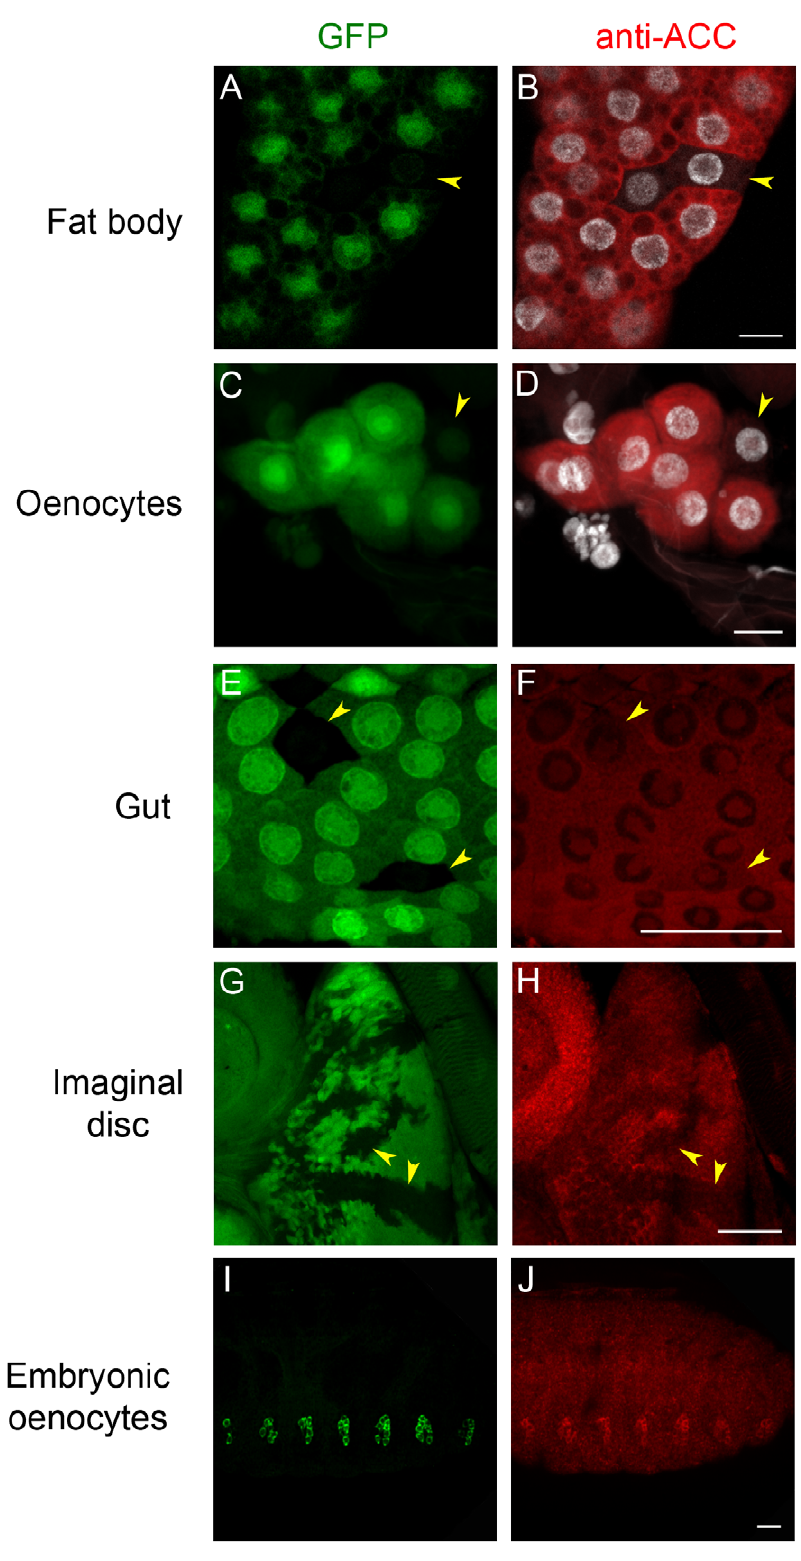
Figure 1. Immunodetection of ACC. Direct GFP fluorescence (A,C,E,G), and staining to ACC (B,D,F,H,J) and nuclei (B,D). ACC expression was very high in the FB (B) and in the oenocytes (D) of L3 larvae, and thus detection was performed with very low laser intensity. The ACC signal was lower in the gut (F) and in the imaginal discs (H) of L3 larvae, and thus detection was performed with high laser intensity. Specificity of the ACC signal was monitored by generating homozygote FRT - ACC B131 clones (identified by the lack of GFP staining; arrowheads in A,C,E,G), which do not express the ACC protein in the corresponding pictures (arrowheads in B,D,F,H respectively). In the embryo, the strongest ACC staining was observed in the oenocytes (J) co-labeled to GFP driven by BO-Gal4 (I). Scale bars: 20 m m. doi:10.1371/journal.pgen.1002925.g001 PLOS Genetics |